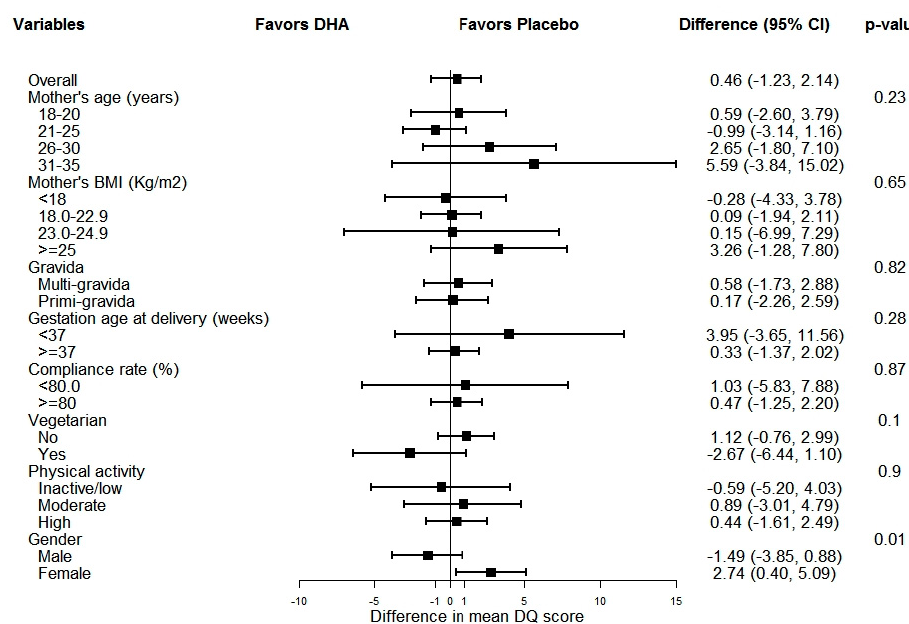
Figure 2. Subgroup analysis . Difference: Placebo minus DHA; Difference in mean DQ score between DHA and placebo group at 12 months was calculated using two-sample t -test for each subgroup; p -value for interaction calculated using linear regression model including interaction term for characteristic of interest and treatment